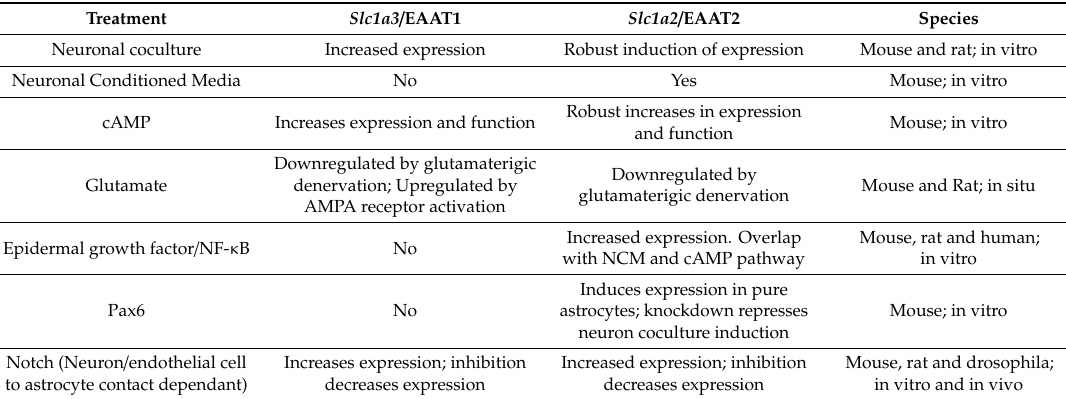
Table 2. Regulation of astrocytic glutamate